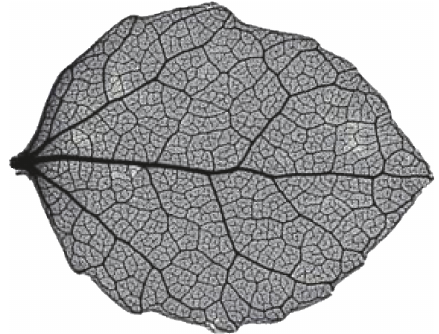
Figure 1: Image of the considered fractal tree-leaf.